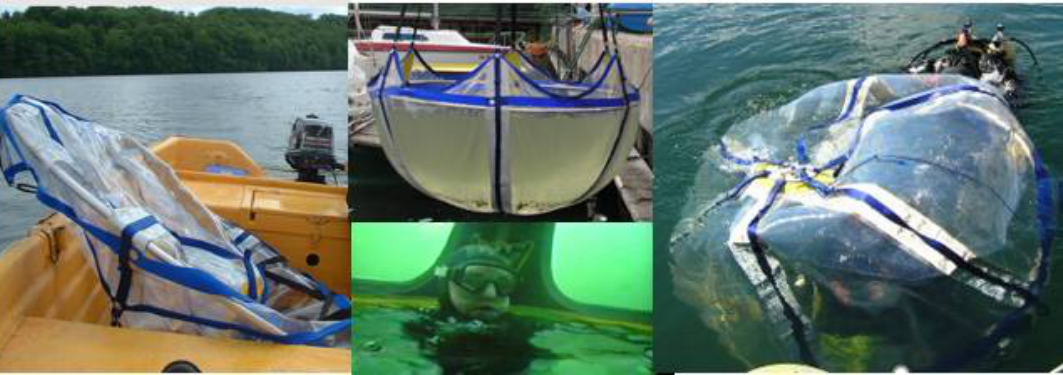
Figure 2. Strength water tests at Lake Radunskie. Source: Photos from own photos research (2022).